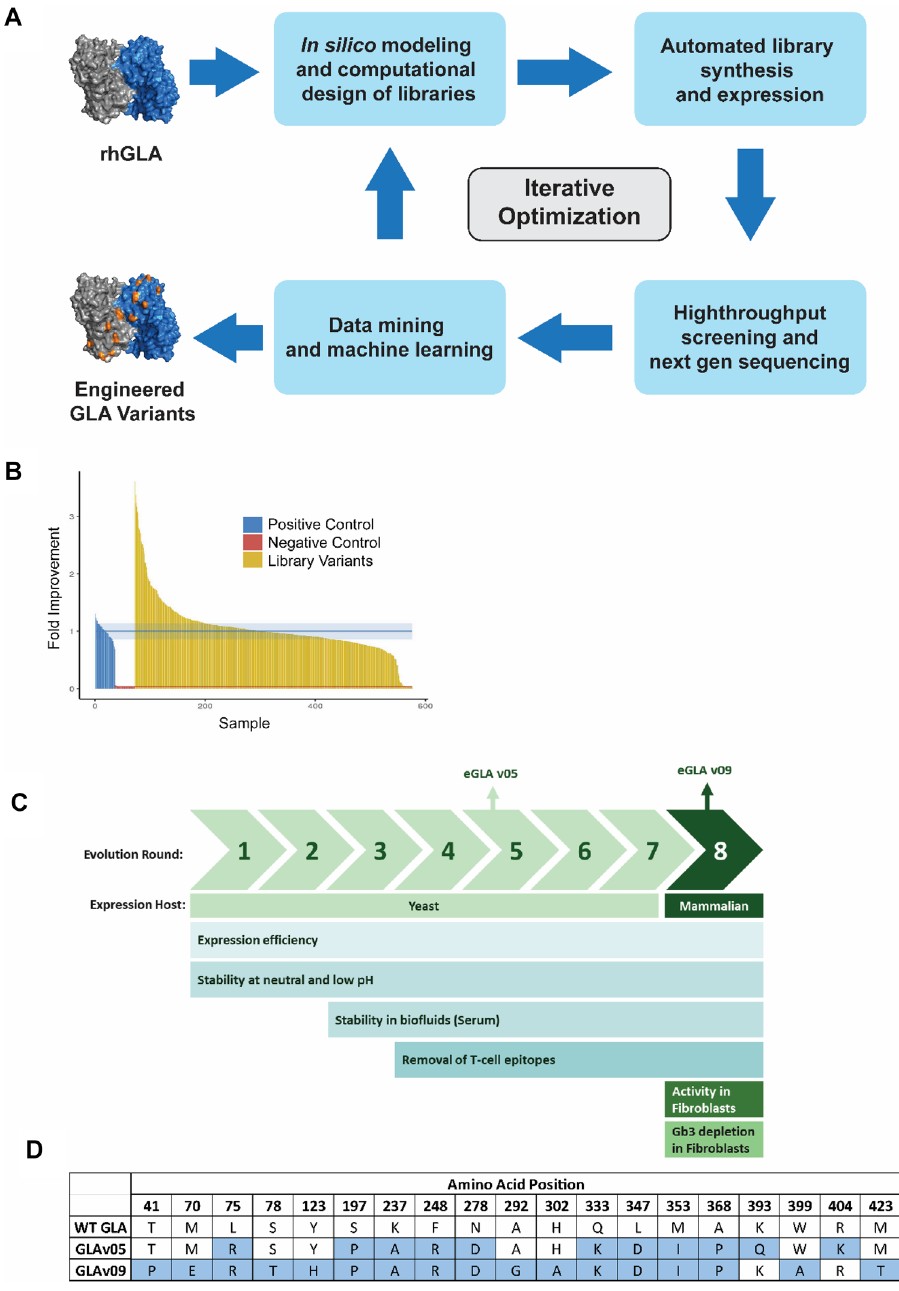
Figure 1. Directed evolution approach for optimizing GLA. ( A ) Enzyme evolution scheme. The published structure of GLA was used to identify positions for mutagenesis in site saturation and combinatorial libraries. Libraries were generated and variants were spatially separated in 96-well plates for screening and DNA sequencing. Beneficial mutations were identified, and the directed evolution cycles were repeated. ( B ) Example of the activity distribution for the Rd 1 GLA variants exposed to pH 7 for 1 h prior to activity measurement. ( C ) Evolution targets and screens over the course of optimization. ( D ) Amino acid changes in GLAv05 and GLAv09 compared to the GLA sequence (Uniprot sequence